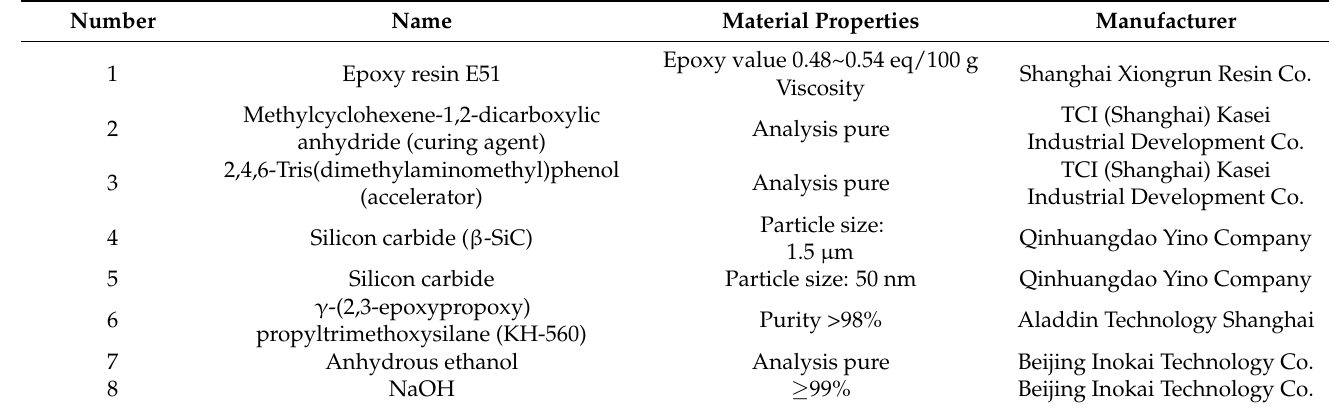
Table 1. Experimental materials used in the